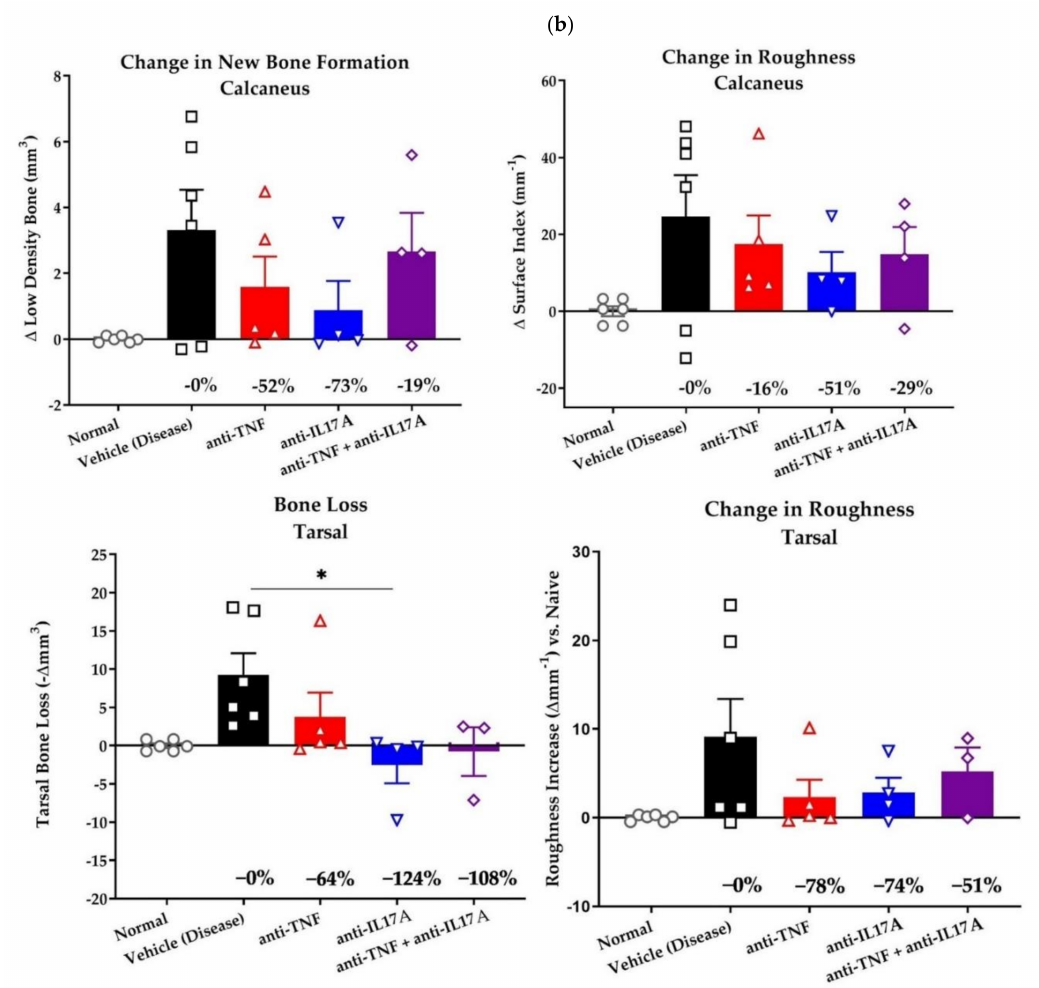
Figure 4. TNF and IL-17A dual blockade therapy affects bone remodeling in peripheral joints. ( a ) Representative micro-CT image of the ankles of HLA-B27/hu β 2m transgenic rats who were treated with anti-TNF and anti-IL-17A (8C11 and B6-17, n = 3–4), anti-TNF (8C11, n = 5), anti-IL-17A (B6-17, n = 4), or PBS ( n = 5). ( b ) Scoring of micro-CT images of calcaneus and tarsal bones of age and gender matched non-diseased rats and the three treatment modalities compared to vehicle control. Numerical, but non-significant, decreases were seen for the dual and both single treatment groups compared to vehicle control for the assessed regions, reaching significance for anti-IL-17A ( p = 0.031) treatment on tarsal bone loss. *, p ≤